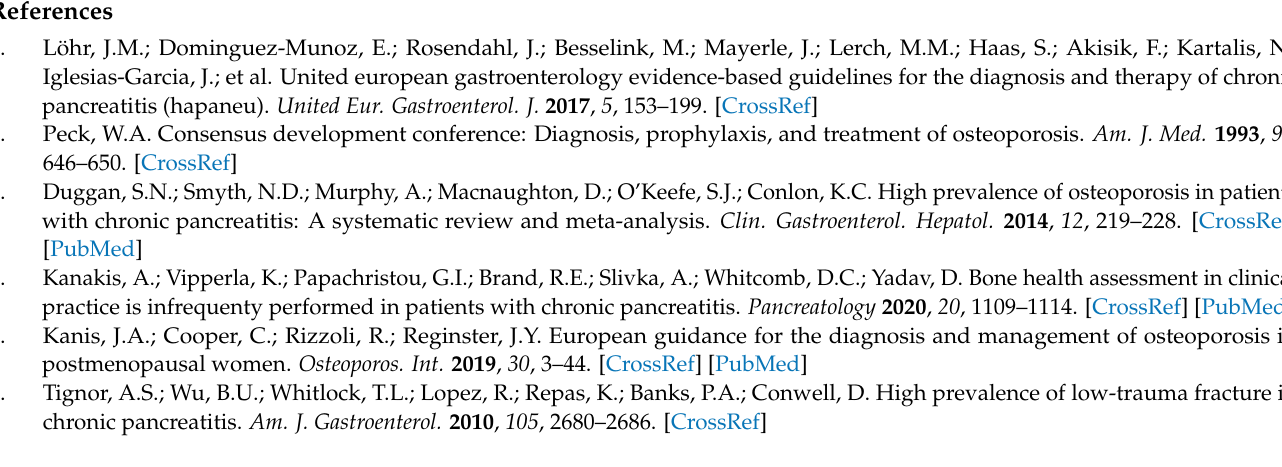
Table S1: Cox regression analysis adjusted hazard ratio (aHR) of fracture events in patients treated with PERT, PPI, Vitamin D, Metformin, Opioids or Steroids during 90 or more consecutive daily regular treatments at any time before the fracture